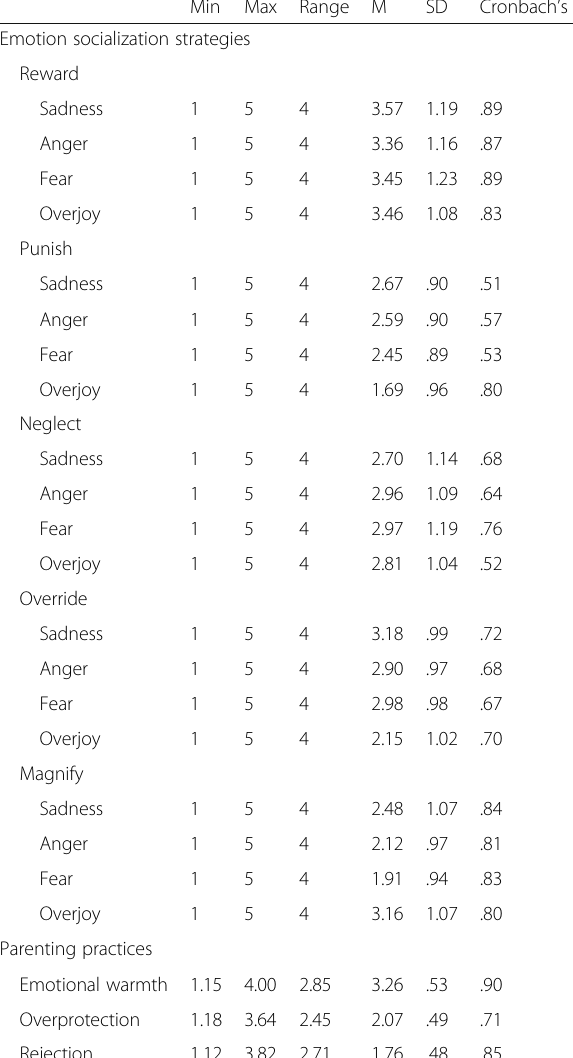
Table 3 Descriptive statistics and Cronbach ’ s α for emotion socialization strategies and maternal rearing practices ( N = 418) Min Max Range M SD Cronbach ’ s α Emotion socialization strategies